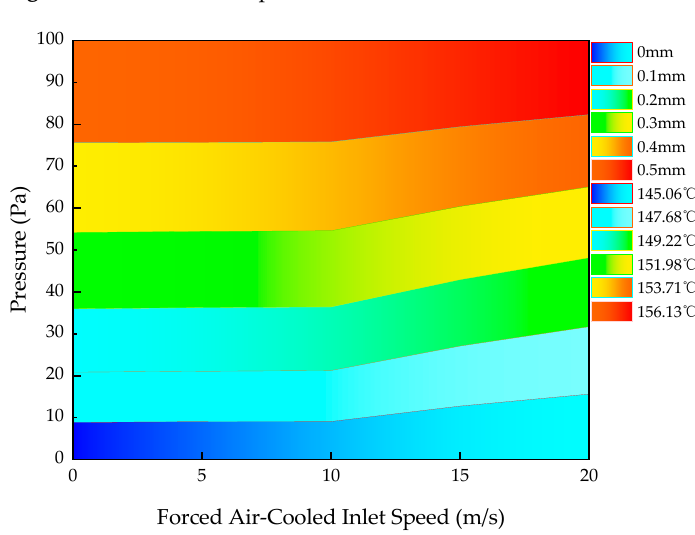
Figure 20. Multi ‐ physics field FE calculation results. Figure 20. Multi-physics field FE calculation